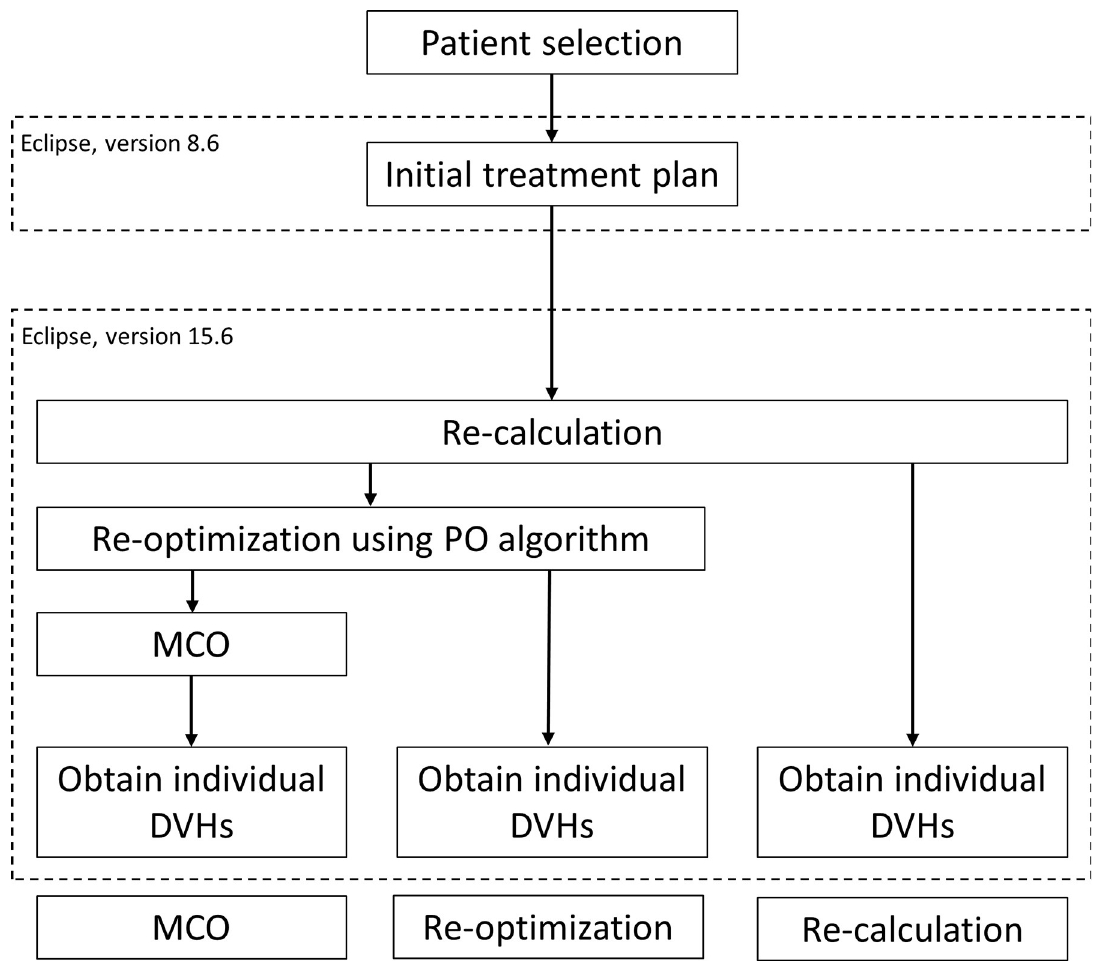
Fig 1. Dosimteric comparison work flow. Abbreviations: PO, Photon Optimizer; MCO, multicriteria optimization; DVH, dose– volume histogram.